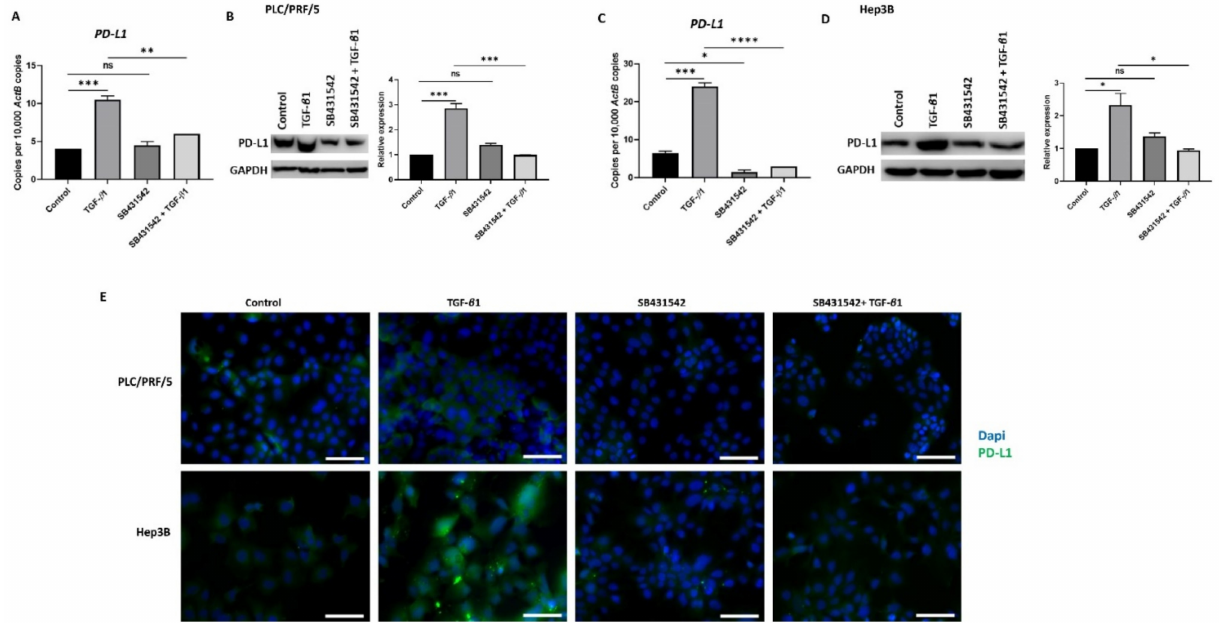
Figure 5. SB431542 inhibits TGF- β 1-induced expression of PD-L1 in HCC cells. ( A ) qRT-PCR and ( B ) western blot analysis revealed reduced expression of PD-L1 in PLC/PRF/5 cells after treatment with TGF- β 1 and SB431542. GAPDH was used as loading. ( C ) qRT-PCR and ( D ) western blot analysis revealed reduced expression of PD-L1 following SB431542 treatment in Hep3B cells. GAPDH was used as loading control. ( E ) Fluorescence microscopy revealed reduced expression of PD-L1 following SB431542 treatment in PLC/PRF/5 and Hep3B cells exposed to TGF- β 1 (scale bar = 200 µ m) ( n = 3, * p < 0.05, ** p < 0.01, *** p < 0.005, **** p <